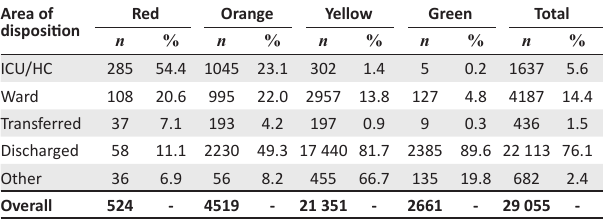
TABLE 6: Distribution of disposition per triage category in a private emergency centre in Pretoria in 2018.